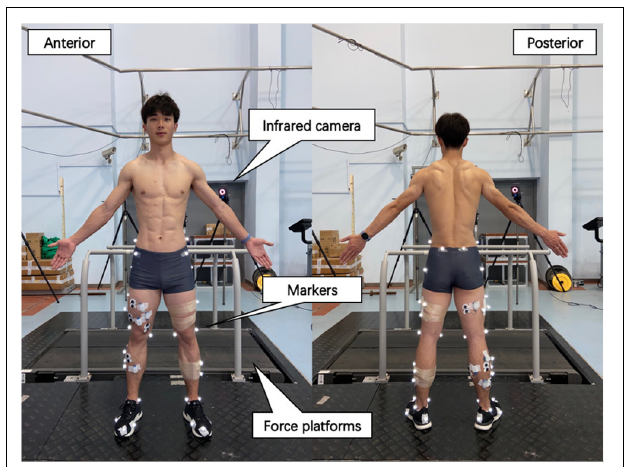
FIGURE 1 | Placement of reflective markers on the leg and experimental site layout. Reflective markers were placed on the following locations to define the hip, thigh, and foot: iliac crest, anterior superior iliac spine, posterior superior iliac spine, femur greater trochanter, femur lateral, and medial epicondyle, fibula apex of the lateral malleolus, tibia apex of the medial malleolus, first and fifth metatarsal heads, posterior surface of the calcaneus, and the surface of the toe. Markers in the T stand were used as tracking thigh and